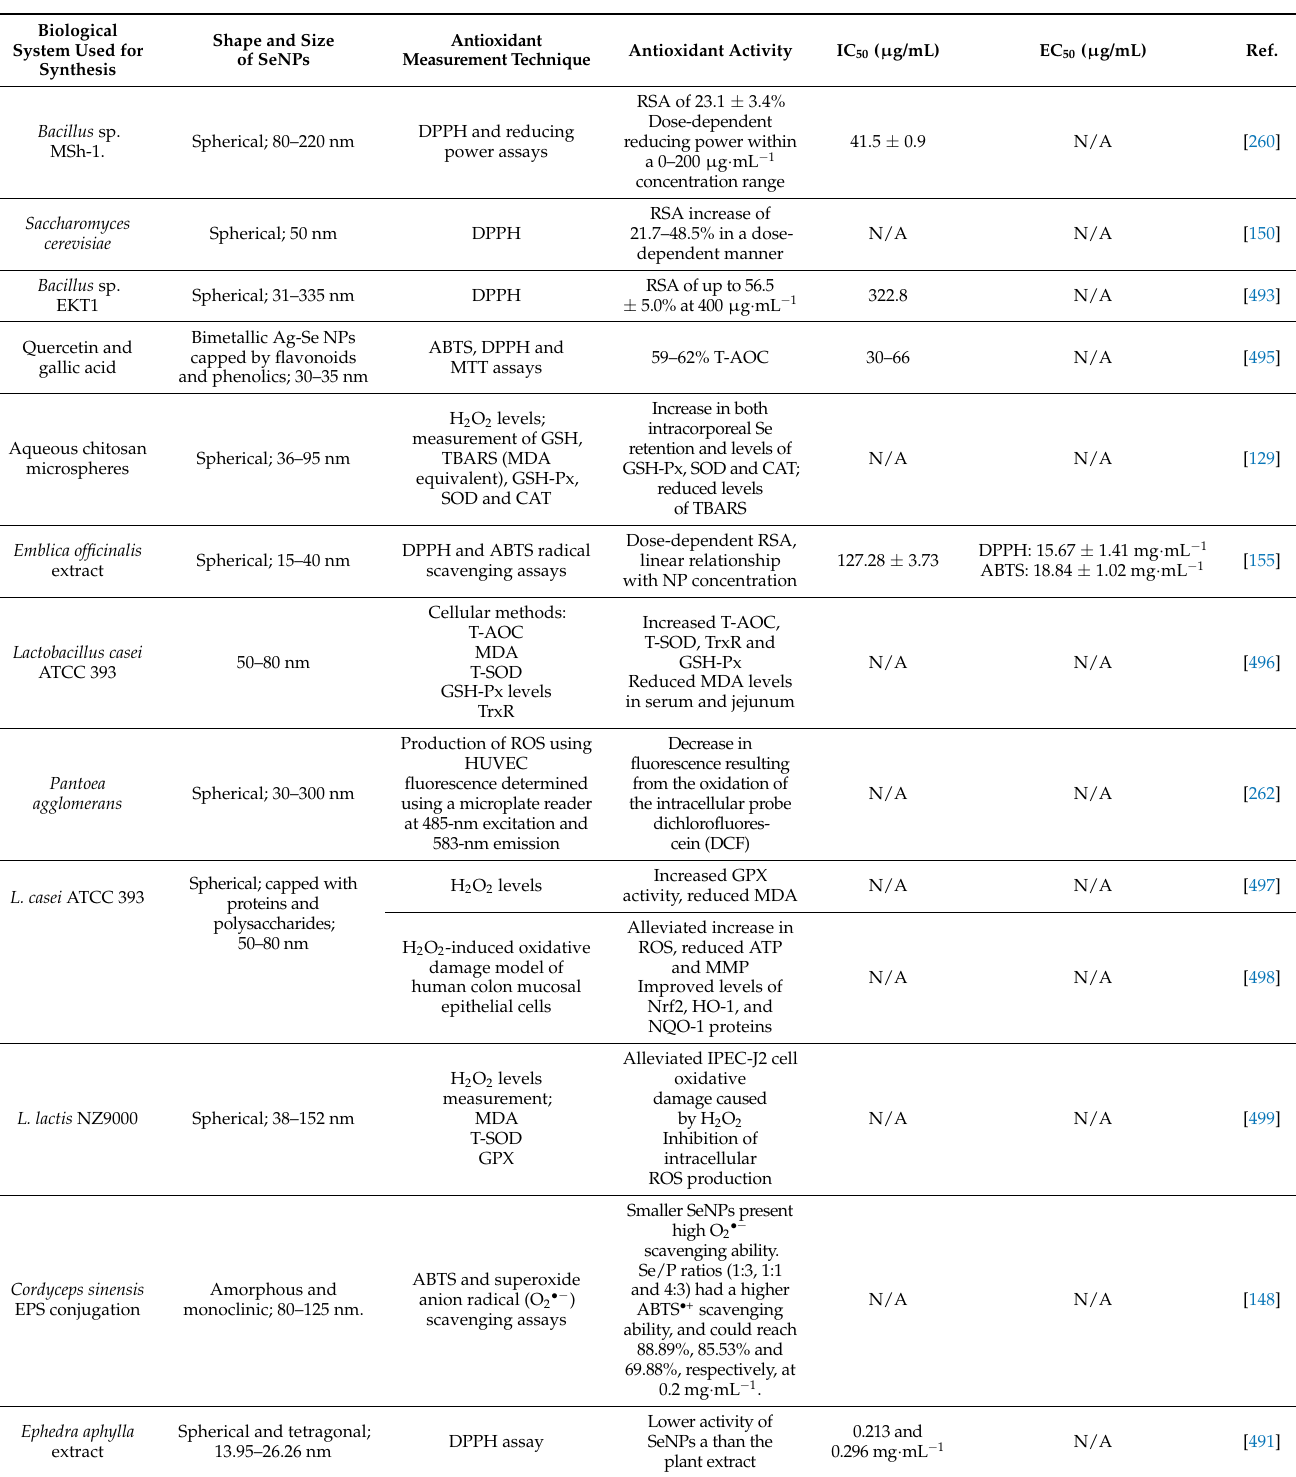
Table 3. Antioxidant activity of biogenic SeNPs: Biosynthetic route, NP features (size and shape), methods used and main